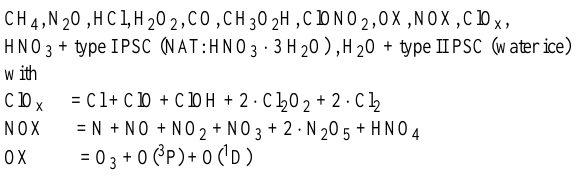
Table 1. Transported chemical species and